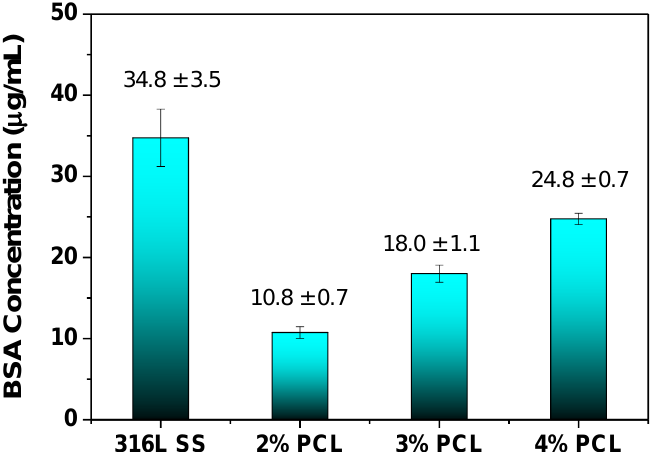
Figure 5. The BSA adhesion concentrations for the bare 316L SS and 316L SS coated with 2, 3, and 4% PCL films, determined from the BCA protein assay.